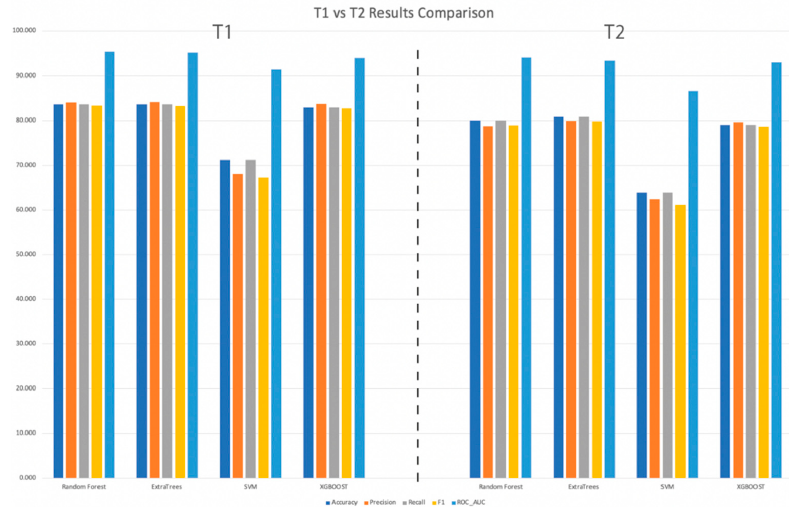
Figure 6. Results using S1HT1 versus S1HT2 datasets. Table 11. Composition of datasets.